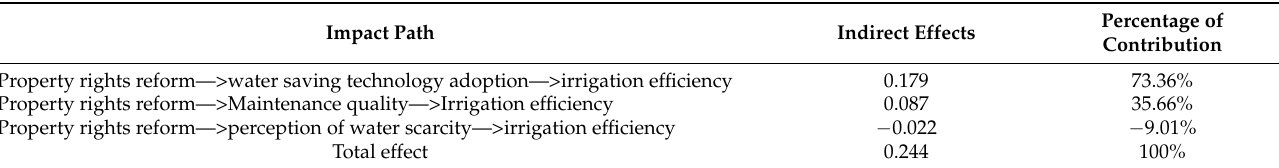
Table 10. Indirect and total effects of property rights reform of farmland water facilities on irrigation